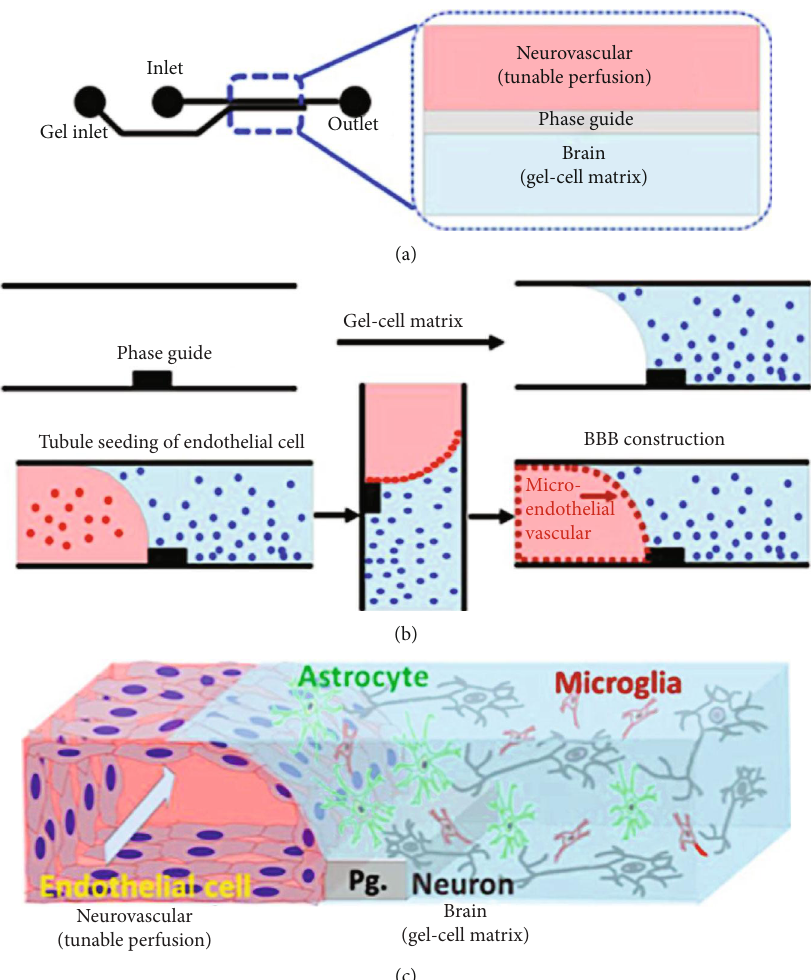
Figure 27: 3D brain construction for high content OP toxicity screening; (a) structure and format application of in vitro culture ware, (b) experimental procedure for constructing 3D neurovascular/brain compartment, and (c) scheme of 3D tetraculture for brain on chip. Reproduced (or adapted) with permission [133], ©2018,